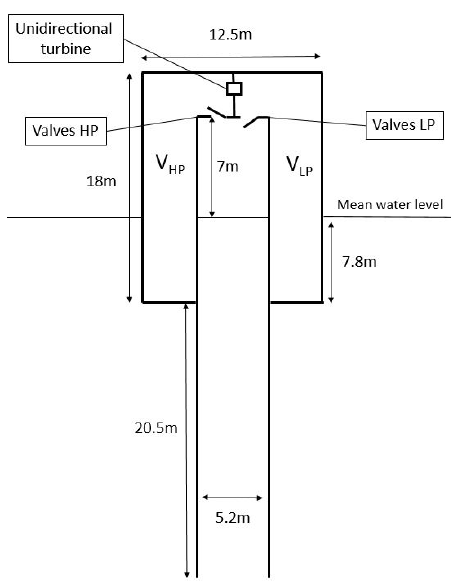
Figure 2. 2D schematic of the full-scale Tupperwave